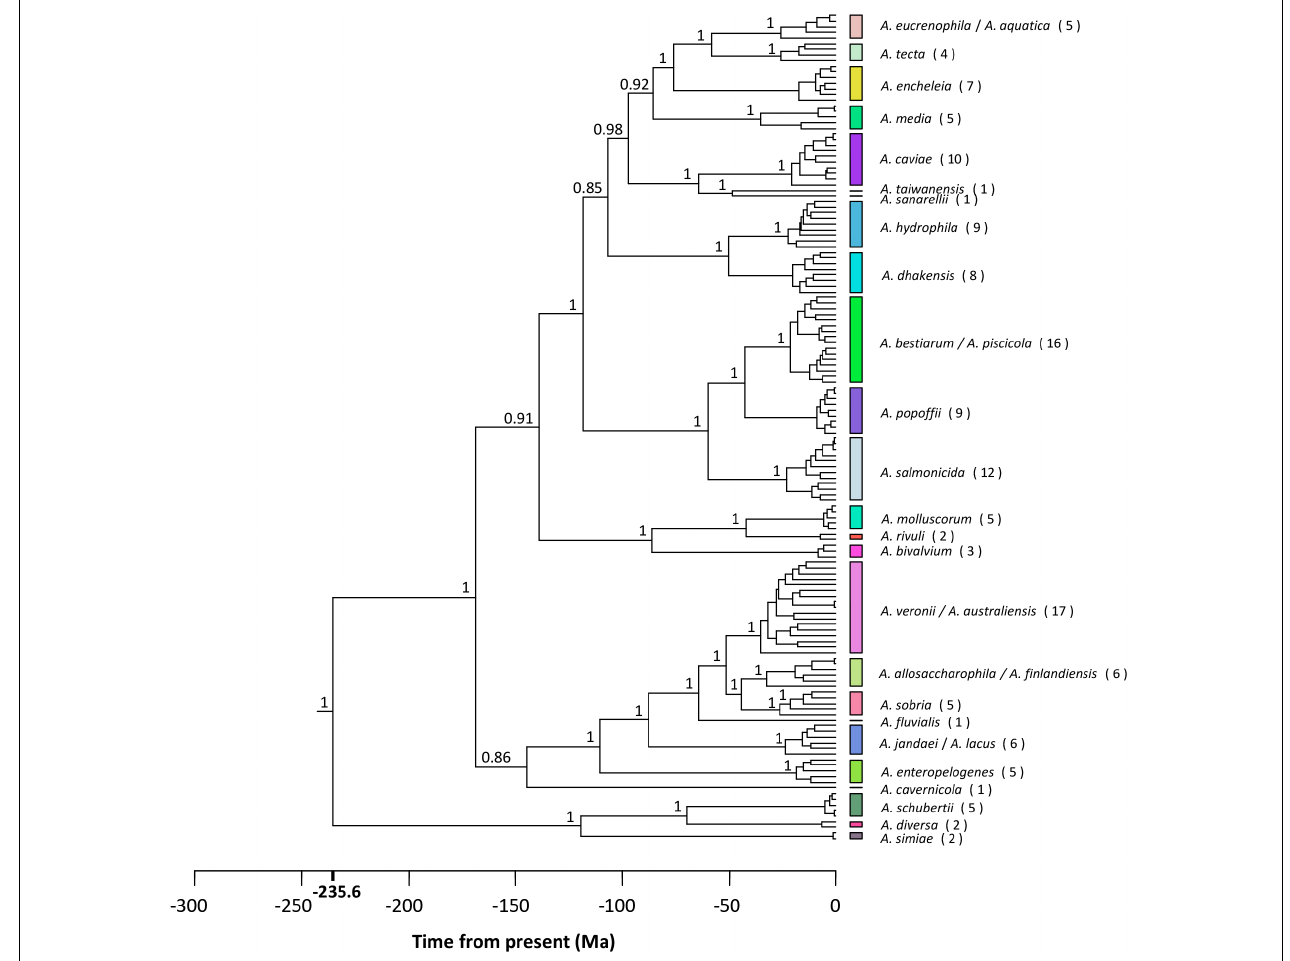
FIGURE 4 | Aeromonas phylogeny. Bayesian chronogram with the posterior probability values for the main clusters. Colored vertical bars on the right correspond to the clusters obtained by the NbClust analysis (Supplementary Table S3). The number of strains belonging to the same species is given in brackets. Scale bar at the bottom indicates the divergence time in millions of years (Ma, Mega